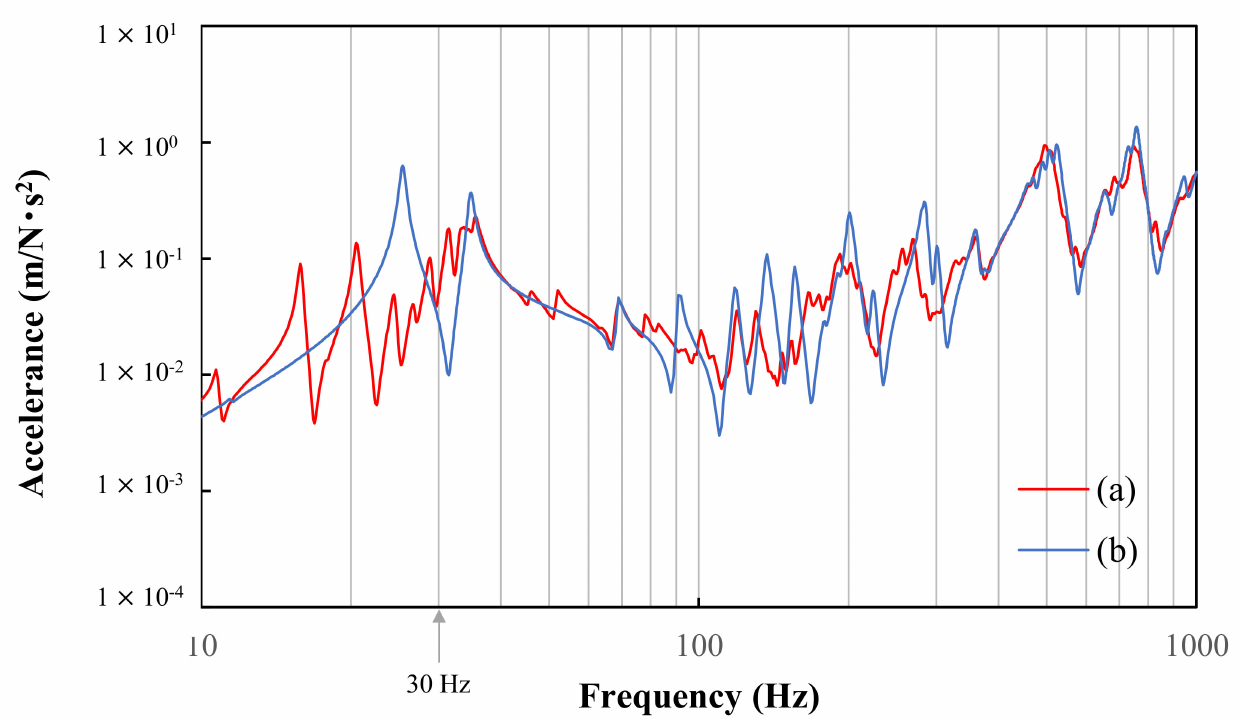
Figure 9. Effect of beam structure on accelerance characteristics. Condition ( a ) is the numerical model with a basic beam structure, while ( b ) is the numerical model with a small beam